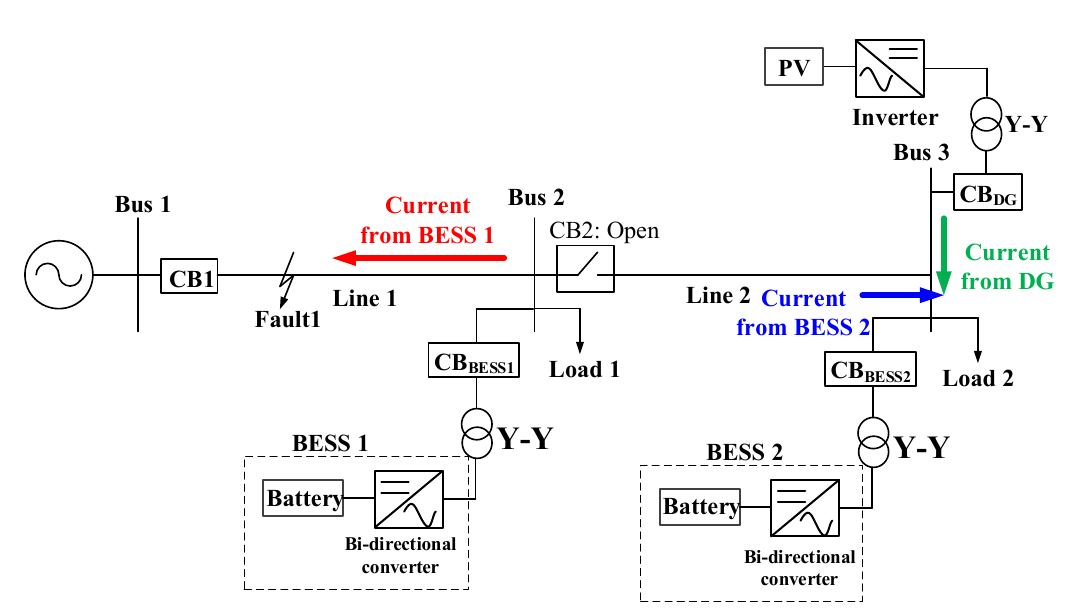
Figure 3. Flow of fault current after circuit breaker 2 (CB2) opening.